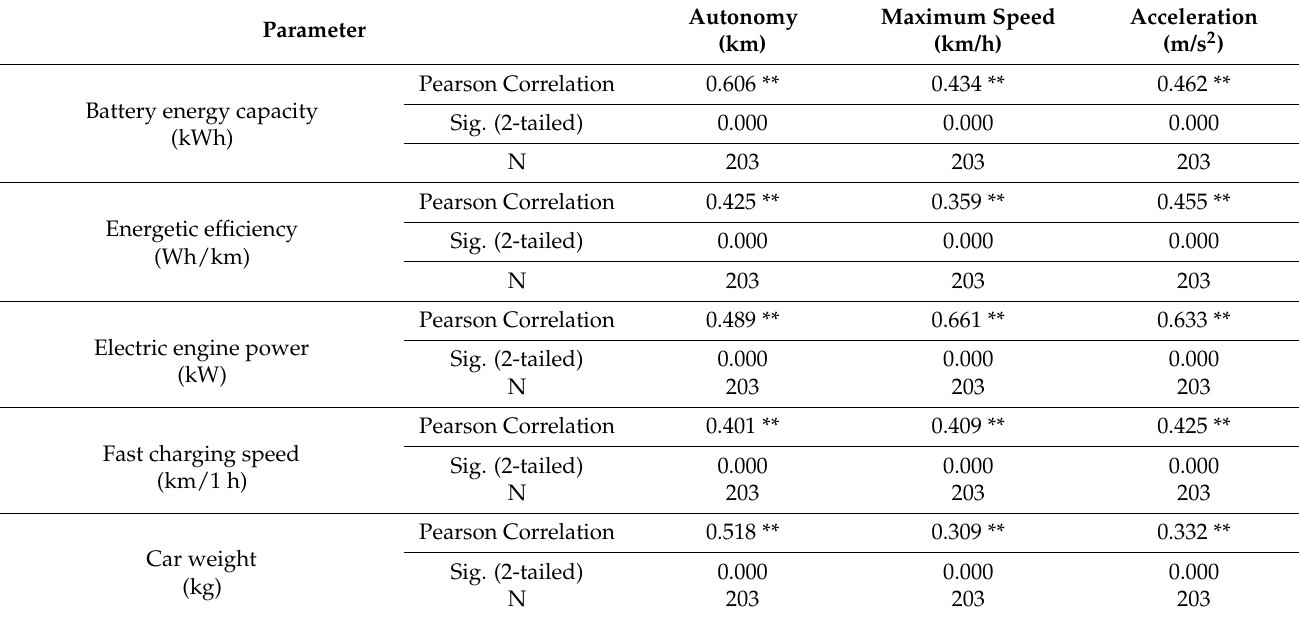
Table 4. Correlation coefficients between the technical and performance parameters of electric